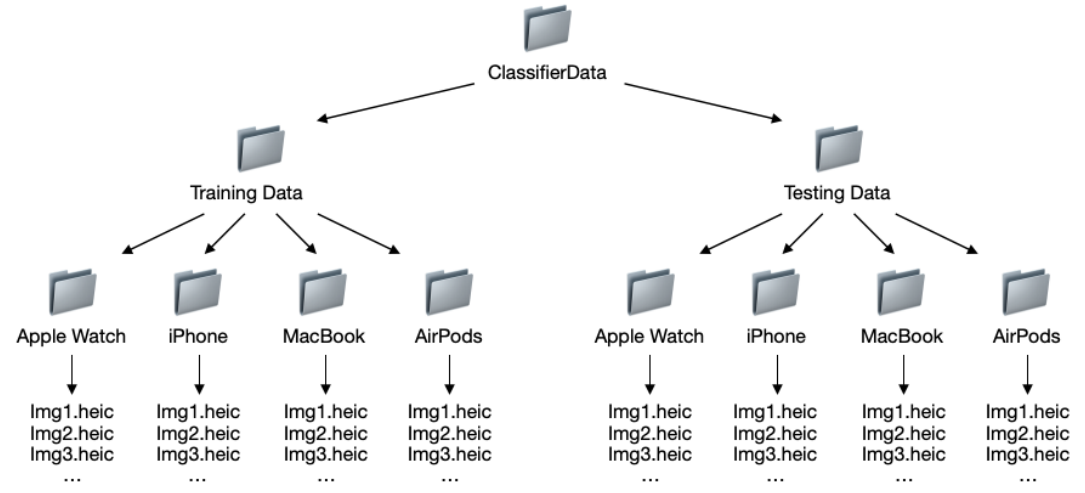
Figure 7. The directory structure in